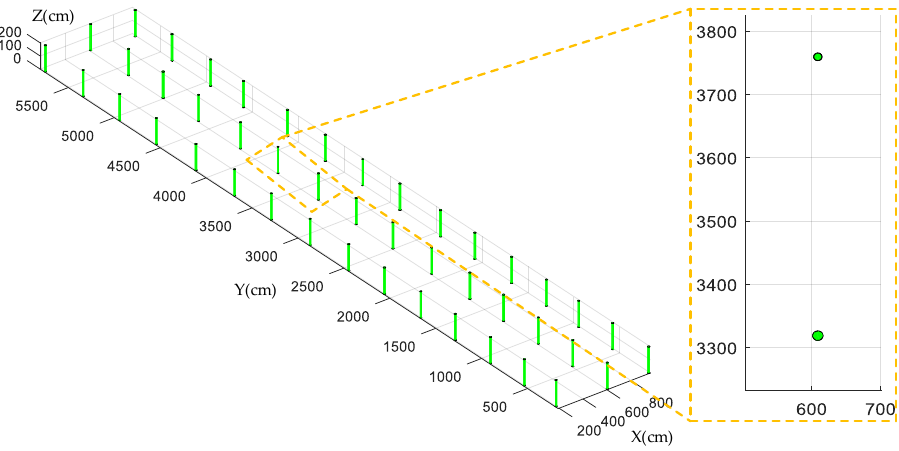
Figure 14. Stopping error distribution.